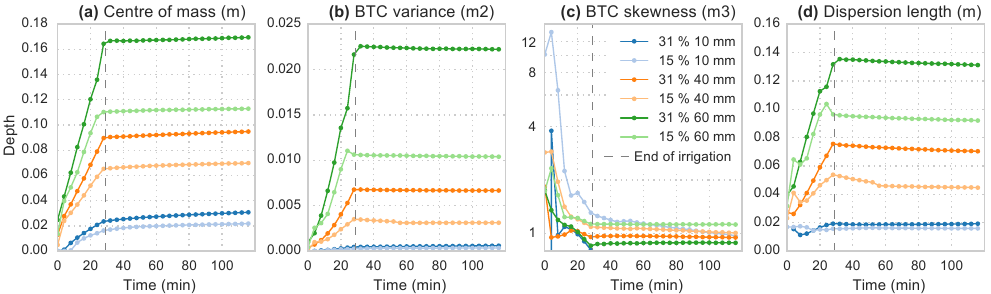
Figure 8. Dynamics of the moments of the breakthrough curves (BTCs) of loamy sand simulations. (a) First moment as centre of mass, (b) second moment as variance of depth distribution, (c) third moment as skewness of depth distribution and (d) dispersion length defined by < A > / < B >